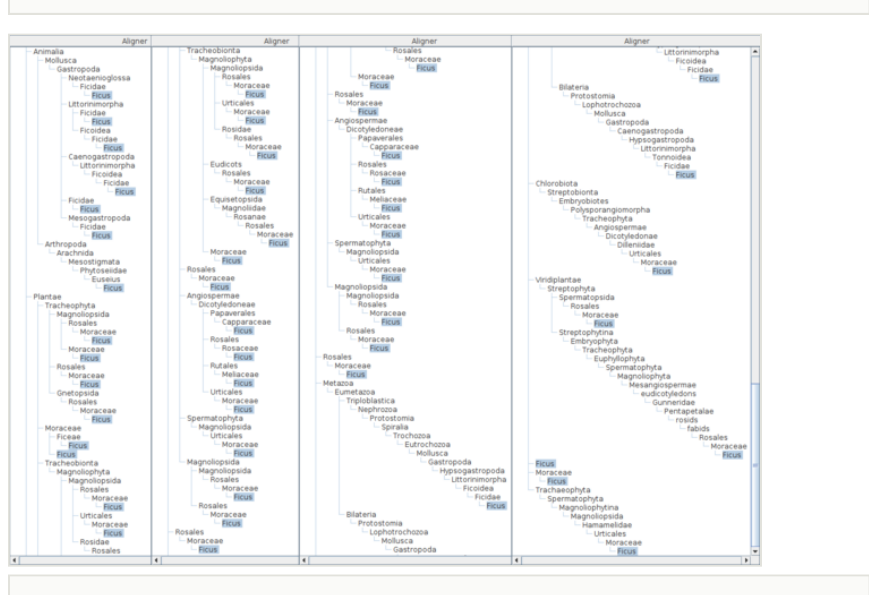
The aligner tree of Ficus from kingdom to genus, as a horizontal composite of four captured screens instead of vertical composition. Some branches are overlapped intentionally to enable con fi rmation of its coverage. There are 36 Ficus branches in the aligner tree for 55 hierarchies compared (not shown). Besides Animalia and Plantae, there are four major branches, starting with Metazoa, Chlorobiota, Viridiplantae and Tracheophyta, which require implicit taxonomic knowledge to evaluate